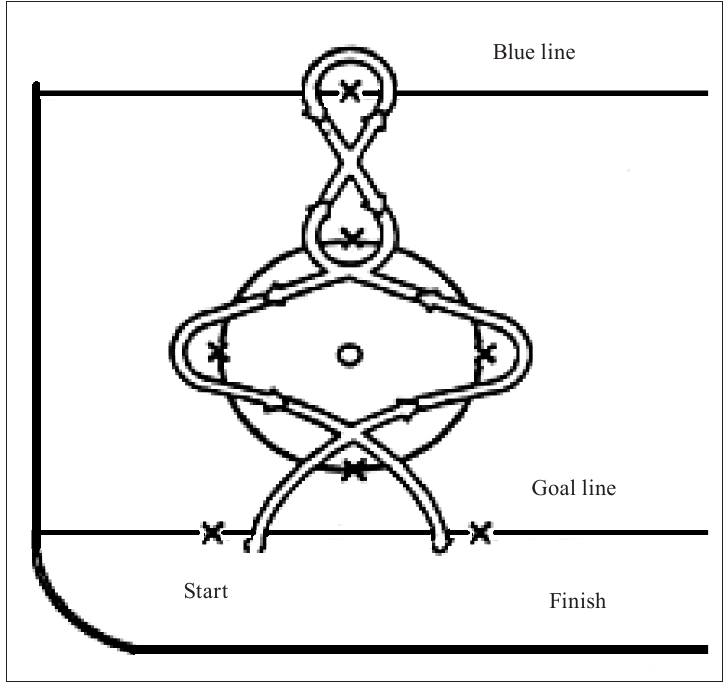
Figure 1. Test to assess the skating technique of ice hockey players (manoeuver skating) (Букатин, Колузганов,